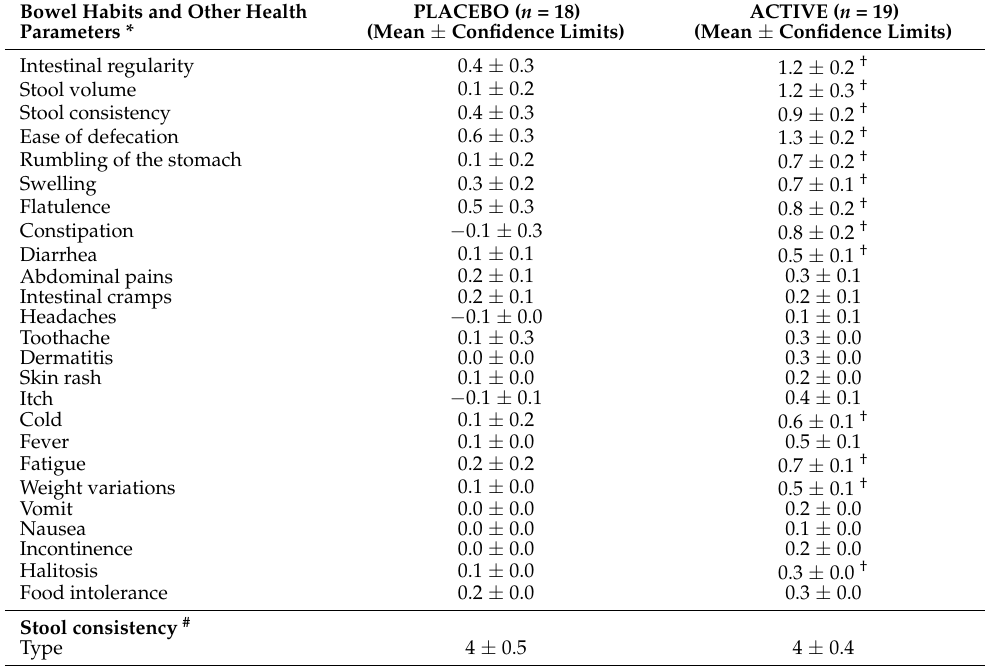
Table 2. Mean absolute changes in bowel habits and other health parameters and stool consistency type over the 4 weeks of the supplementation period. Bowel Habits and Other Health Parameters